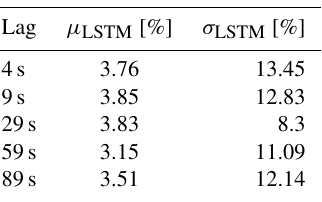
Figure 7. Second LSTM model training input time series generated by HAWC2, down-sampled to 1Hz. Mean wind speed = 9ms − 1 ; mean TI = 10%. Table 4. Sensitivity of the second LSTM model to the hindsight